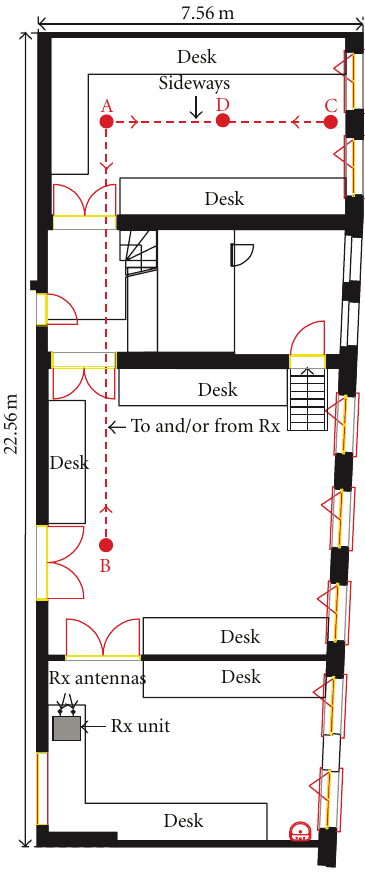
Figure 4: Floor plan of the indoor environment where the measure- ment campaign was